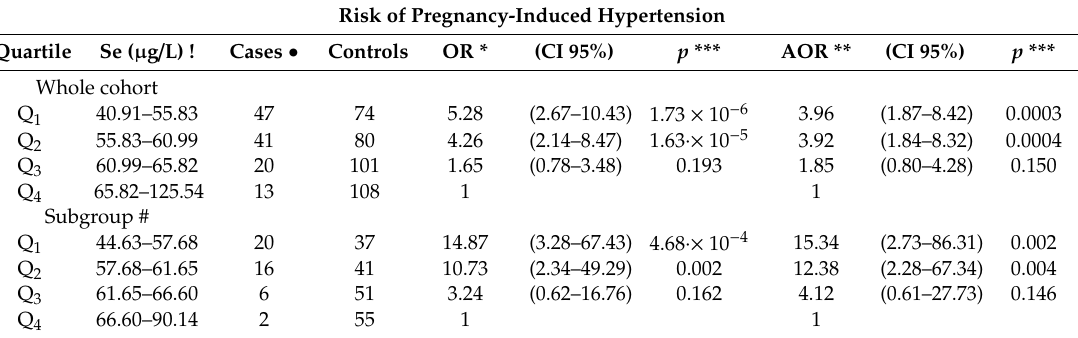
Table 3. The risk of pregnancy-induced hypertension for serum Se levels in univariate and multivariate logistic